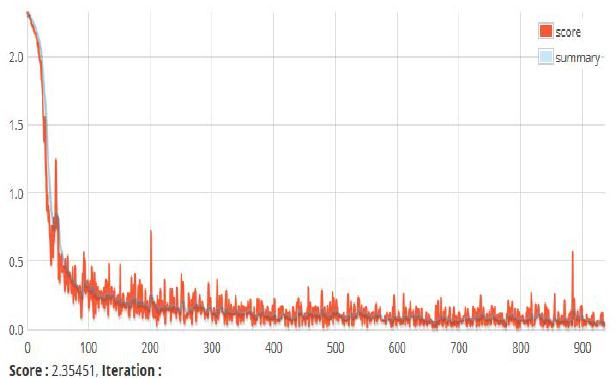
Figure 17. A snapshot of the score versus iteration chart. This shows the value of the loss function of a currently running set of instances. The loss function depicts the mean square error between the actual and target output.